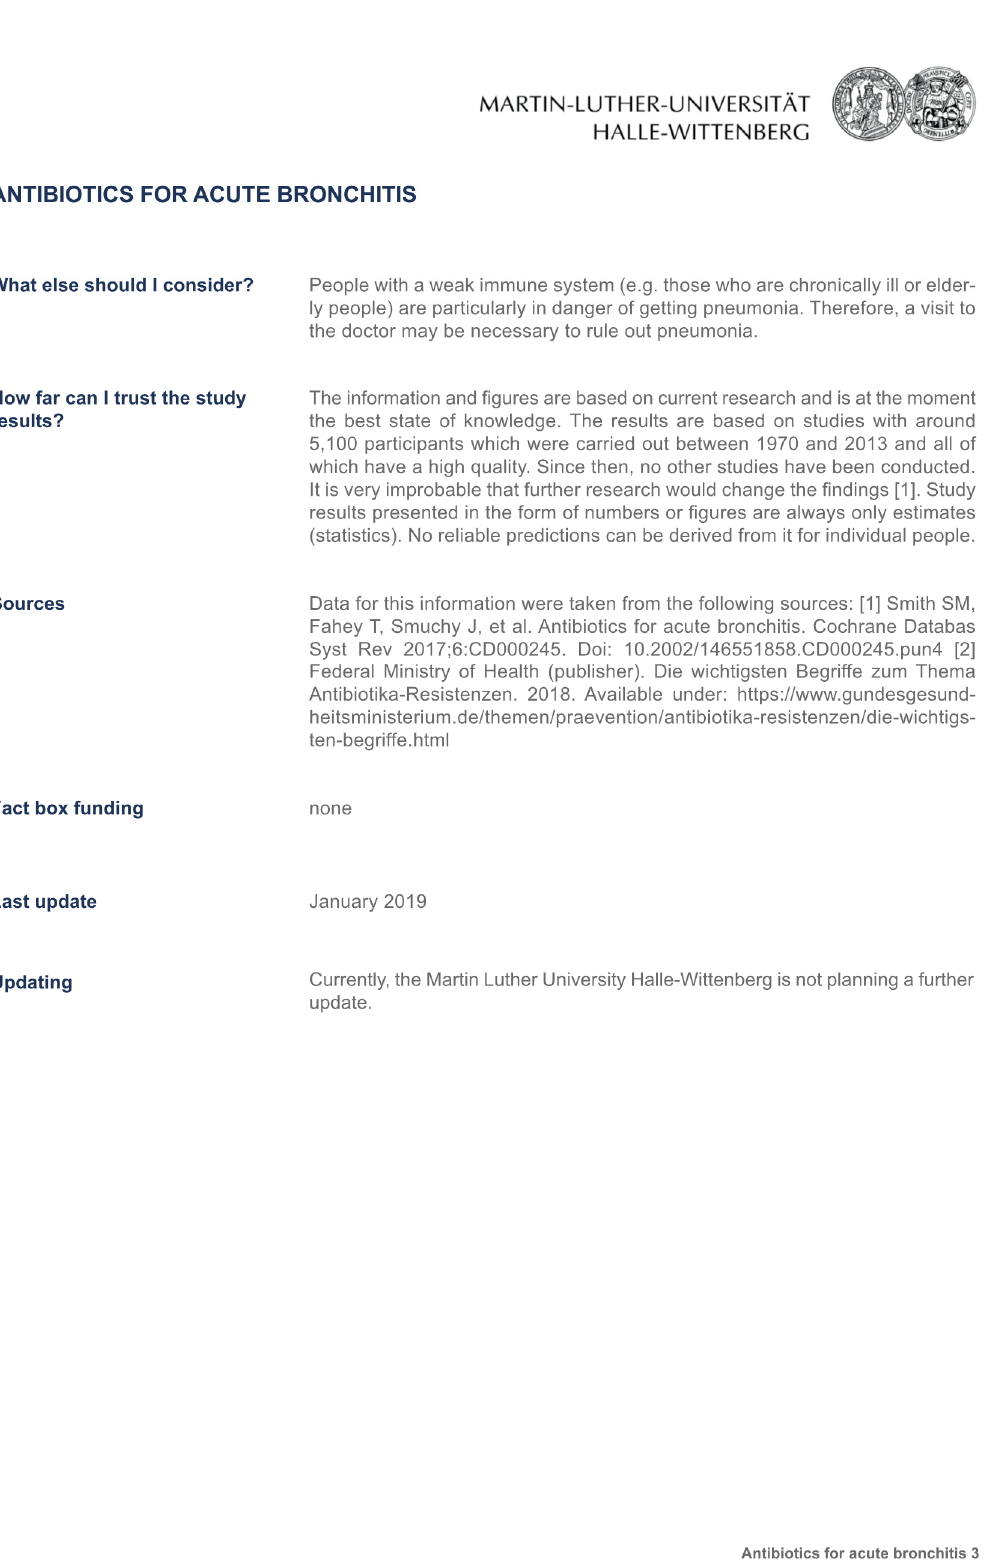
A sample size calculation was not carried out for the pilot RCT